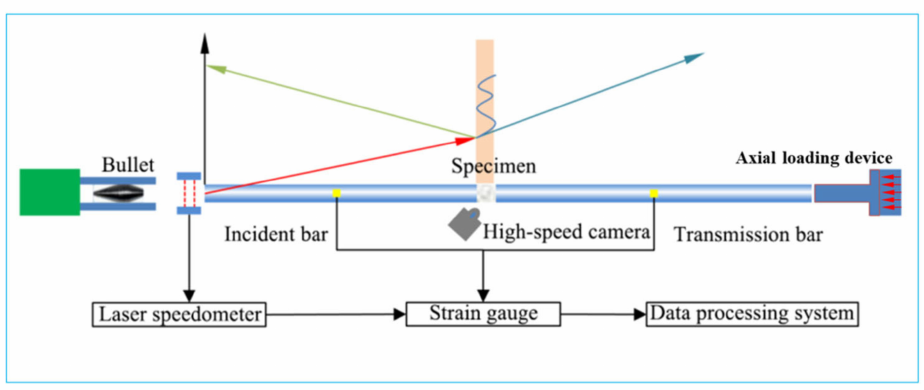
Figure 1. SHPB test